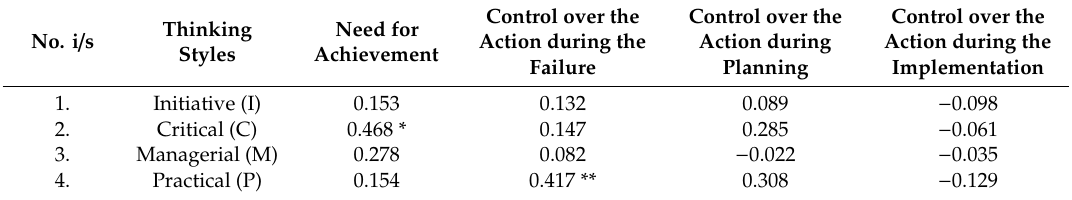
Table 1. Table of correlation relations of thinking style and motivational tendencies in Group